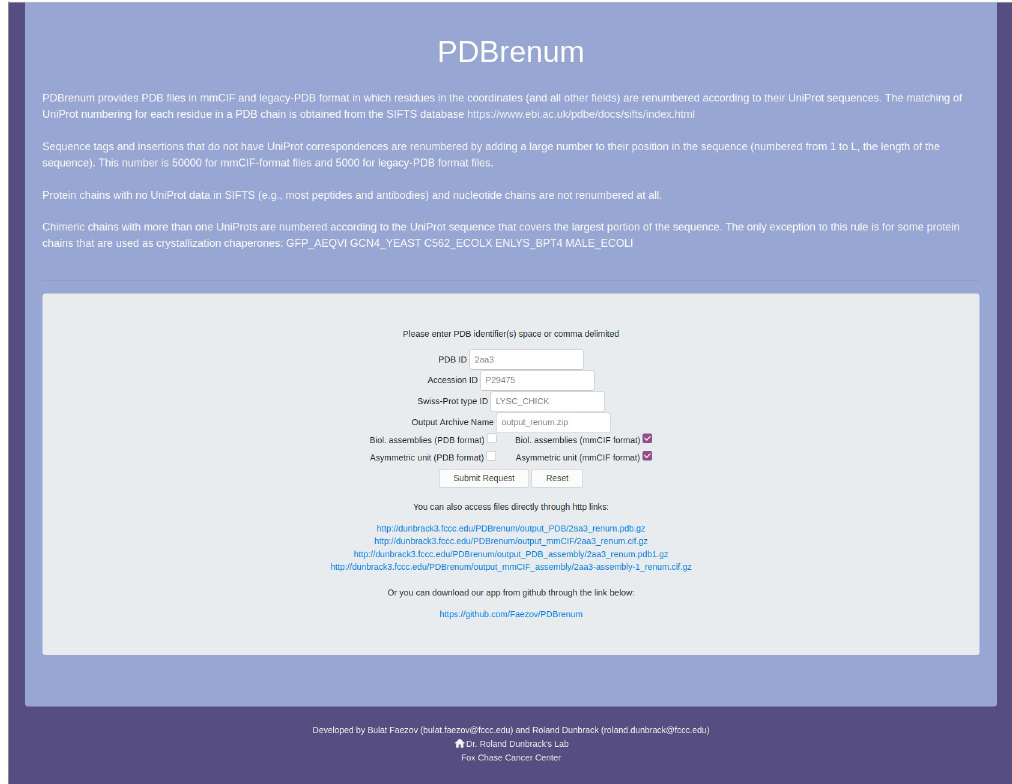
Fig 6. Screenshot of the PDBrenum server. The server takes in a list of PDB entry codes (comma, space, tab, or newline separated) or a list of UniProt (e.g. P38398) or SwissProt (e.g., BRCA1_HUMAN) accession codes. The user can choose whether to obtain mmCIF and/or PDB-format files, and whether to obtain asymmetric units and/or biological assemblies with check boxes. If more than one file is requested, a zip file is returned, and the name of this file can be specified.